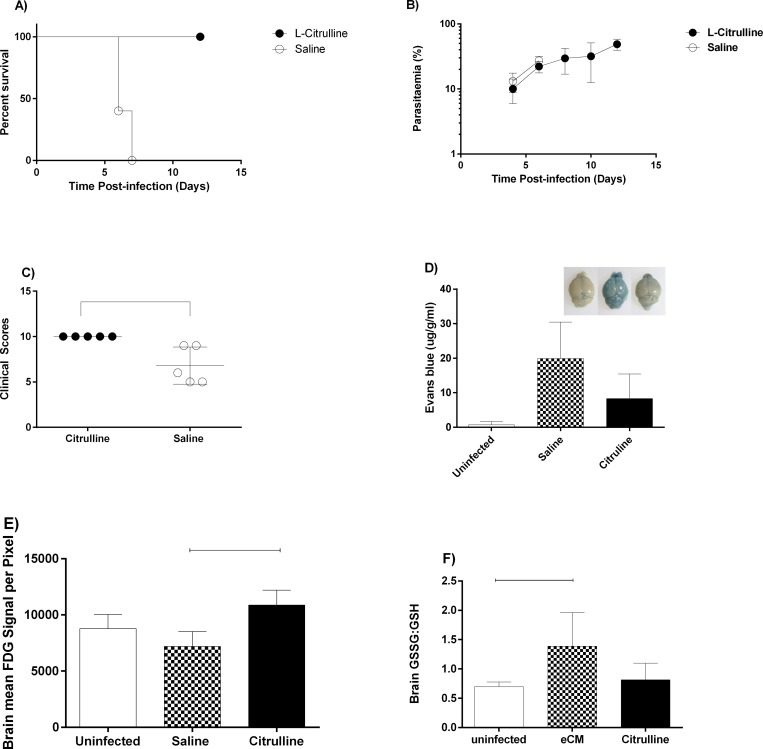
Citrulline as a nutraceutical protects against eCM.Groups (n = 5) of mice were injected i.v. with PbA and then injected twice daily ip with citrulline (nutraceutical) or saline. (A): survival, (B): parasitemia (mean % ± stderr) timecourse, and (C): clinical scores of citrulline- and saline-injected mice infected with PbA. This experiment was repeated 4 times with similar results. Citrulline; Arginine (D): Vascular leak into brain measured by Evans Blue dye extrusion into brain parenchyma in groups (n = 5) of mice on day 6 PI (eCM) treated with citrulline as a nutraceutical or vehicle controls. Inset: representative images of brains after Evans Blue extrusion. This experiment was repeated with similar results. (E): Average pixel intensity PET brain images in groups (n = 5) mice infected with PbA and treated with citrulline nutraceutical or saline and compared with uninfected controls. This experiment was performed once. : p<0.05. (F): Brain GSSG:GSH ratios in groups (n = 5) of mice infected with PbA and treated with Citrulline or saline twice daily i.p and compared to uninfected, untreated controls. Analysis performed by Metabolon inc (Morrisville, NC) using mass spectrometry.